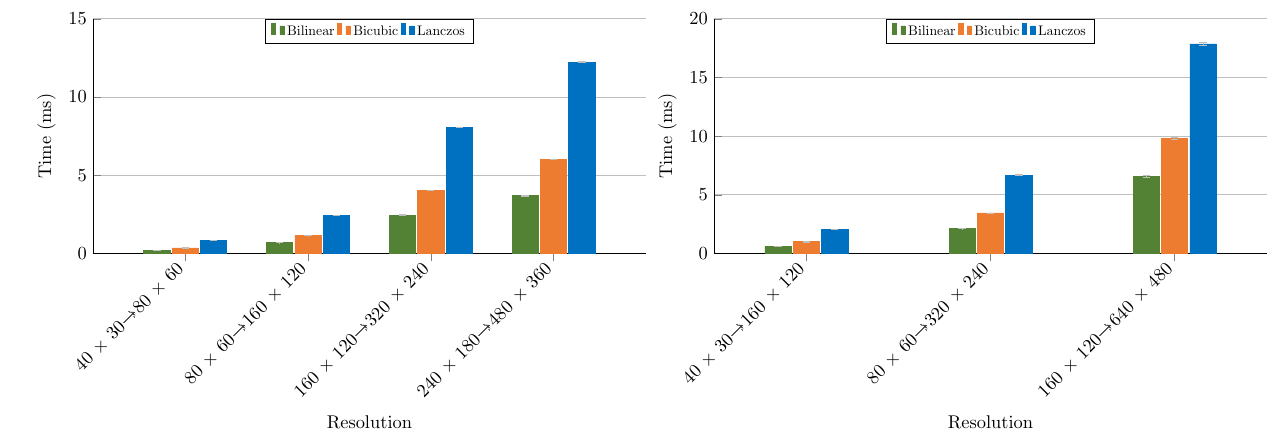
Figure 15. Time for rescaling the heatmap for different resolutions by a factor of 2 ( left ) and by a factor of 4 ( right ). The gray lines indicate the confidence interval.